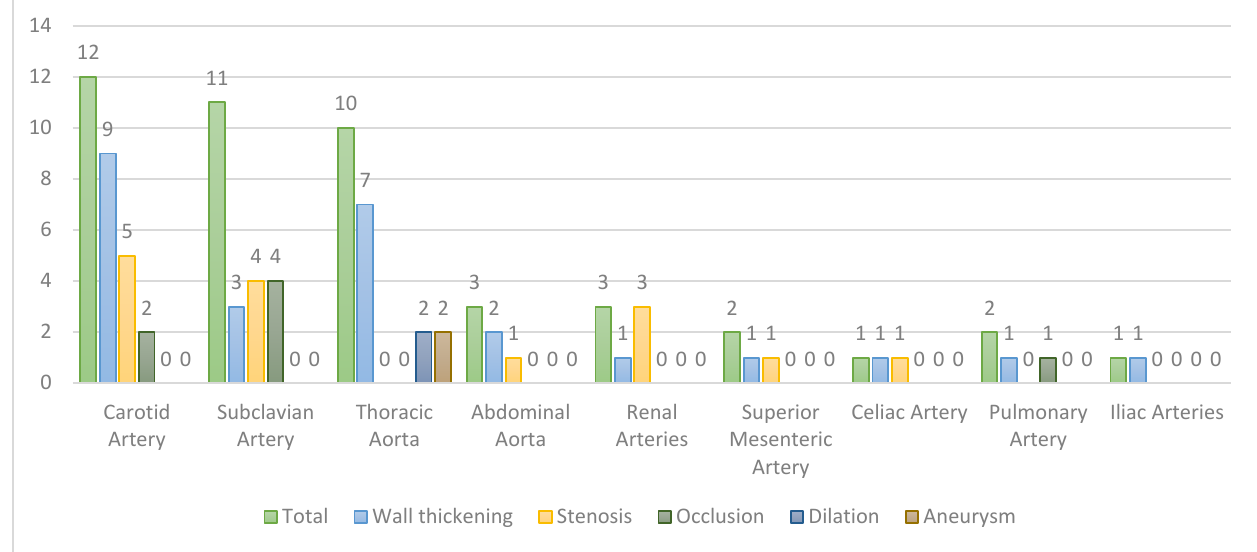
Figure 1. Extracranial vessel abnormalities found on imaging including wall thickening, stenosis, occlusion, dilation, and aneurysm.